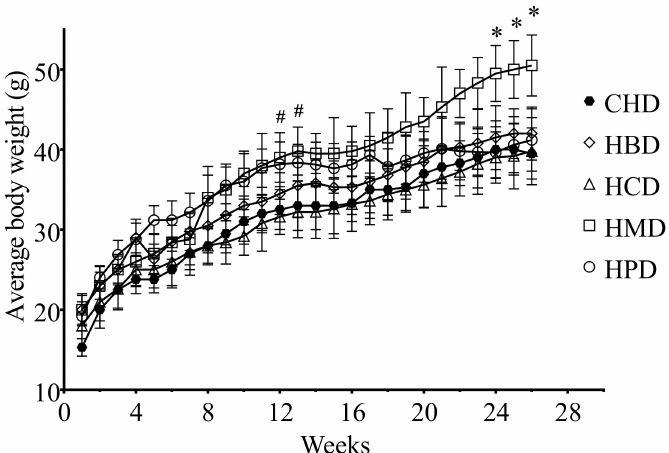
Figure 1. Body weight gains of 6-month diet mice. Each dot and error bar represent the mean value and standard deviation from four to five animals. * p < 0.05, HMD versus CHD; # p < 0.05, HPD versus CHD. CHD, control high fat diet; HBD, high beef tallow diet; HCD, high cocoa butter diet; HMD, high milk fat diet; HPD, high palm oil